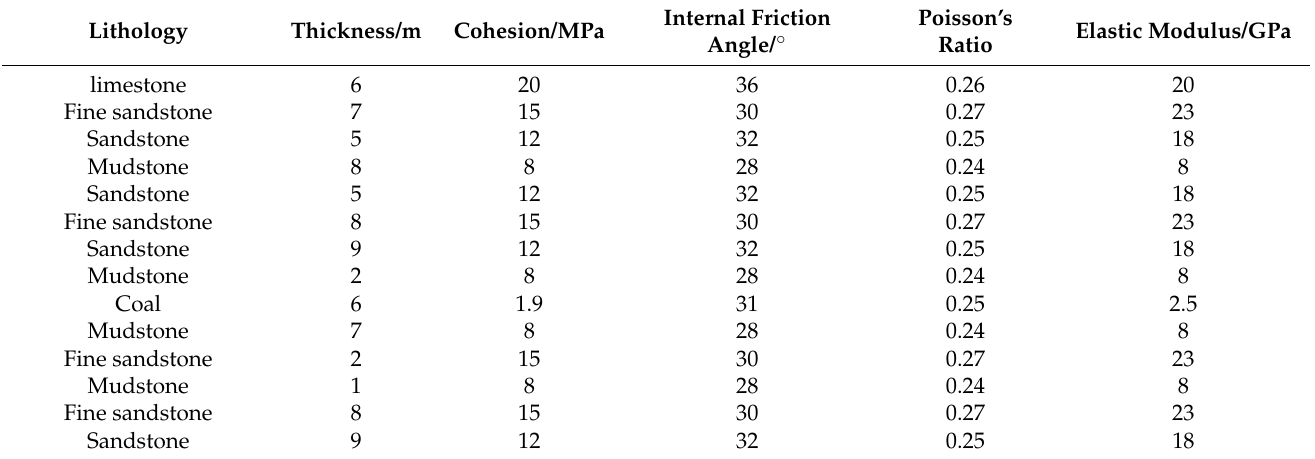
Figure 5. Horizontal stress evolution as the working face advances from 20 m to 140 m. 3.2. Permeability Variation of Coal-Rock Mass during the Mining Process We investigated the permeability variation of the coal-rock mass during the mining process in Figure 6. The permeability enhancement appears above the goaf and varies with the pressure-relief area induced by the advanced working face. Similar to the stress variation, the permeability enhancement is limited to a small area above the excavated coal-rock mass with a maximum permeability of 140 mD. In contrast, the permeability of other areas remains unchanged as the working face is advanced to 20 m (Figure 6a). It